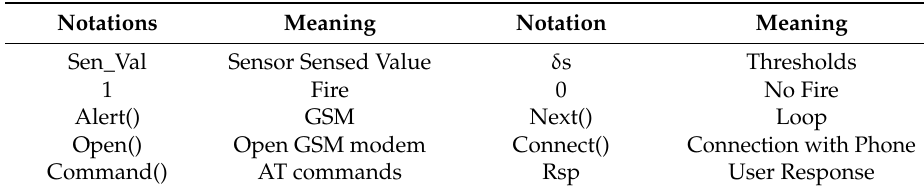
Table 2. Notations used in the